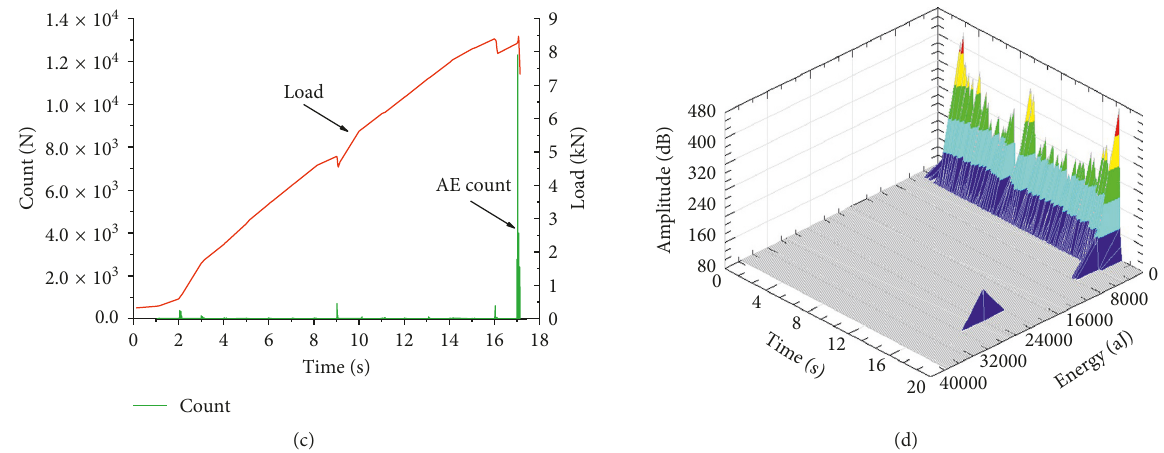
Figure 9: AE characteristics of the basalt columnar joints under saturated state: (a) AE amplitude and time, (b) AE energy and time, (c) AE count and time, and (d) AE amplitude, energy, and